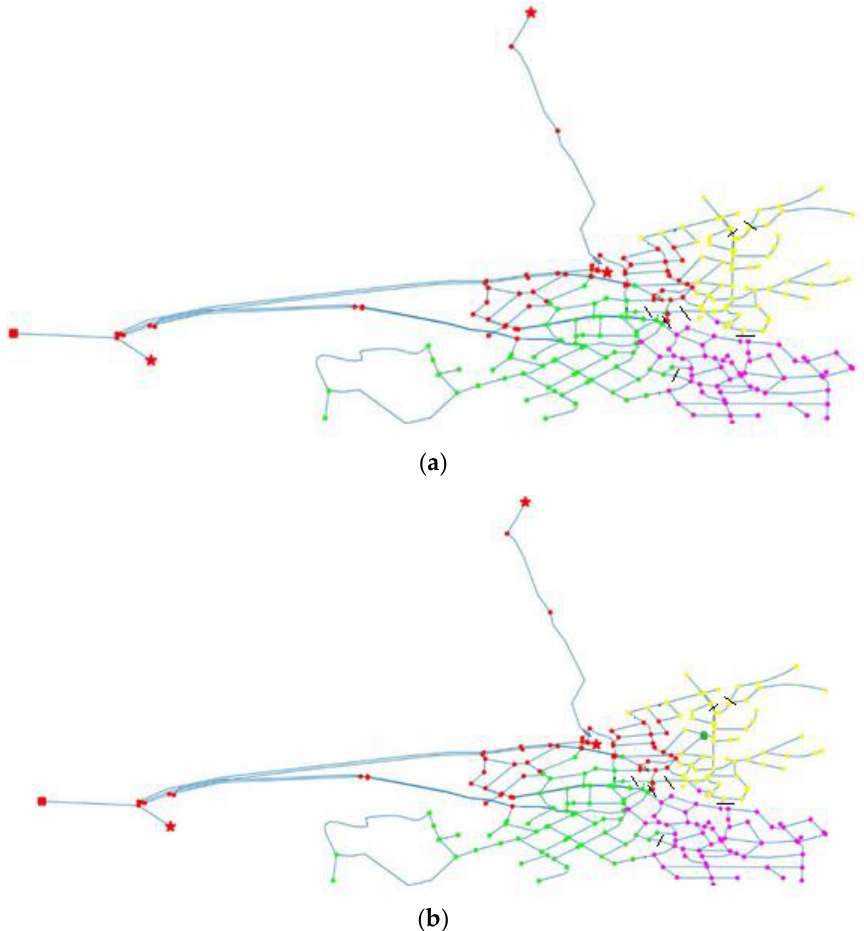
Figure 8. ( a ) The pipes chosen for closing using SMM-EM (black lines), and ( b ) the selected junction for PRV installation (green circle).